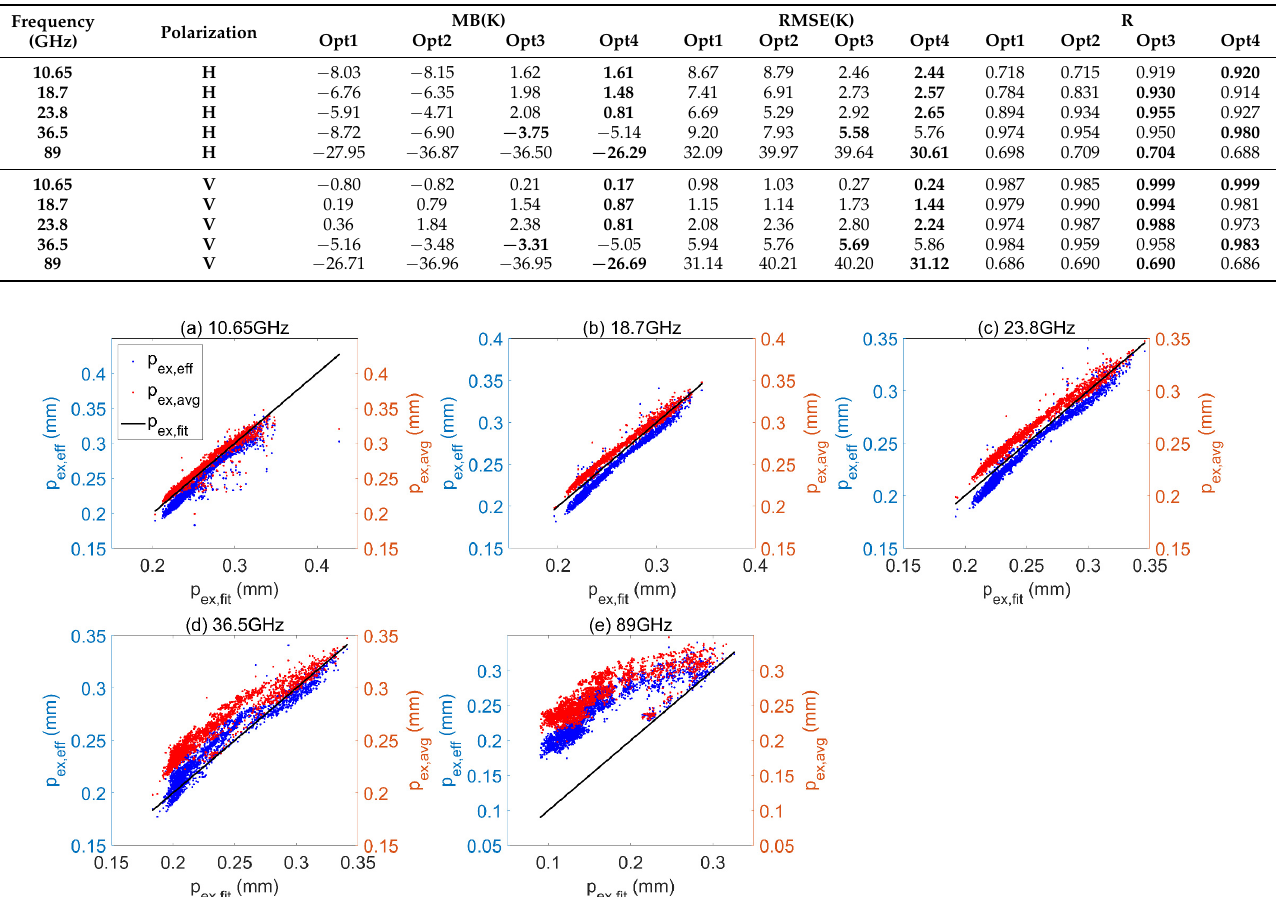
Table 4. Statistics for mean bias (MB), RMSE and correlation coefficient (R) of simulated brightness temperature in different bands and polarizations (global samples). The sample size was 2487. The values in bold represent the highest accuracy among four methods.